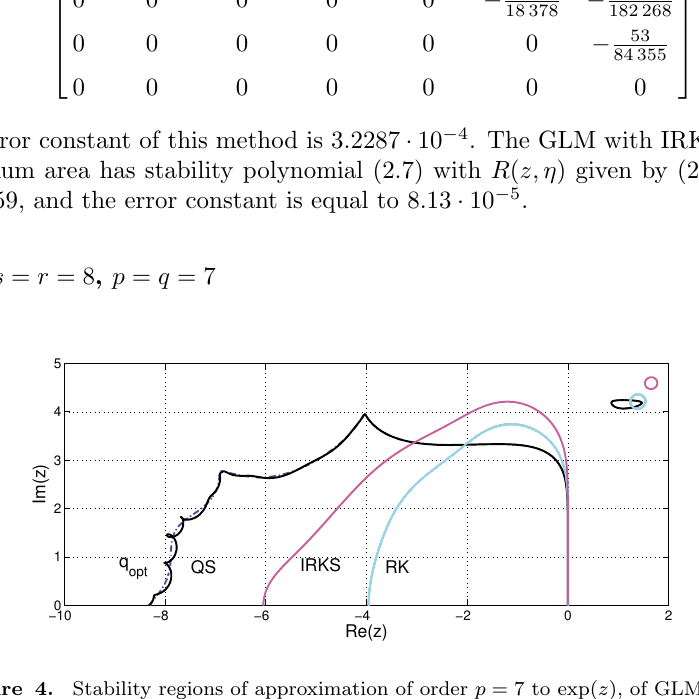
Figure 4. Stability regions of approximation of order p = 7 to exp( z ), of GLM with IRKS corresponding to η = 0 . 61, of GLM with s = 8 and p = 7 with QS with residual 1 . 03 · 10 − 7 , and of optimal quadratic polynomial q opt . Observe that the stability region of q opt is quite close to stability region of GLM with